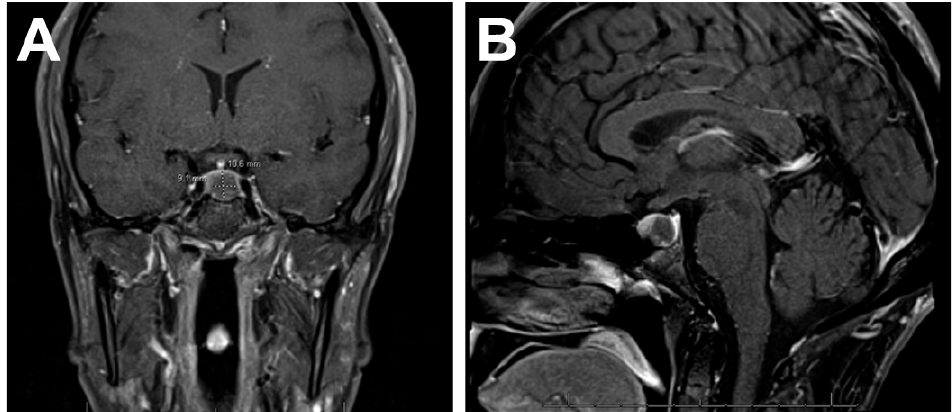
Figure 3. Coronal ( A ) and sagittal ( B ) T1-weighted MRI of a patient being treated with pembrolizumab that began experiencing signs of pituitary apoplexy with headache and extreme fatigue. T1 hypointense lesion is visible in the posterior left aspect of the pituitary gland, which is in the region of the previous T1 hyperintense posterior pituitary bright spot. Pathological analysis showed fragments of anterior and posterior pituitary gland with marked mononuclear inflammation and CD3+ T cell infiltrate. Reprinted with permission from Ref. [45] Copyright 2021. John Wiley & Sons.